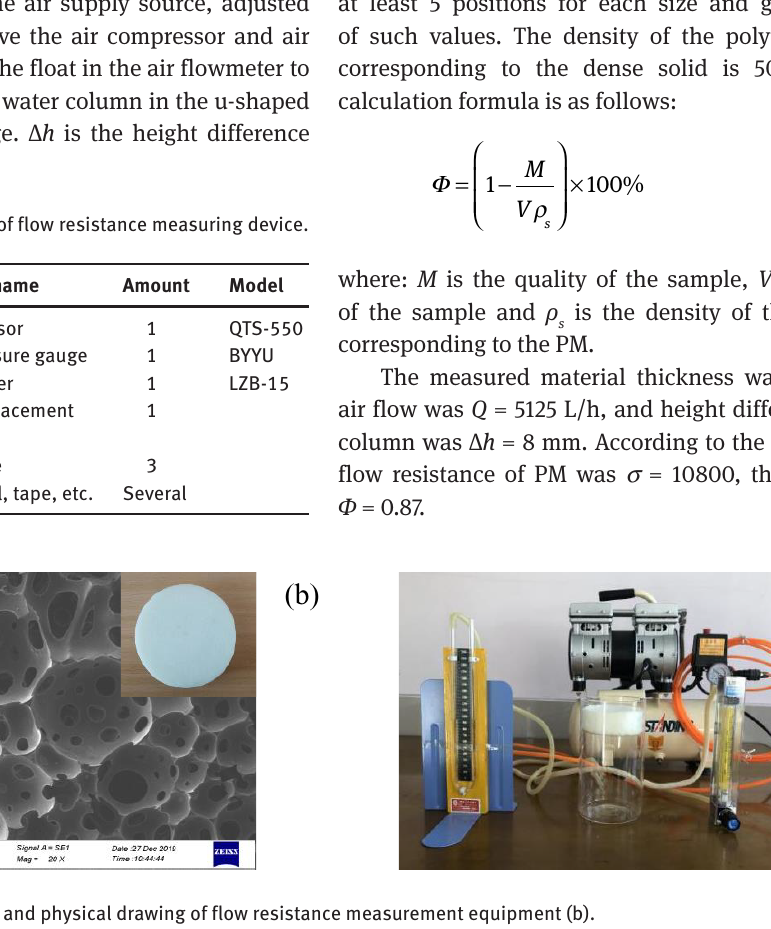
Figure 3: SEM of sample PM (a) and physical drawing of flow resistance measurement equipment (b).